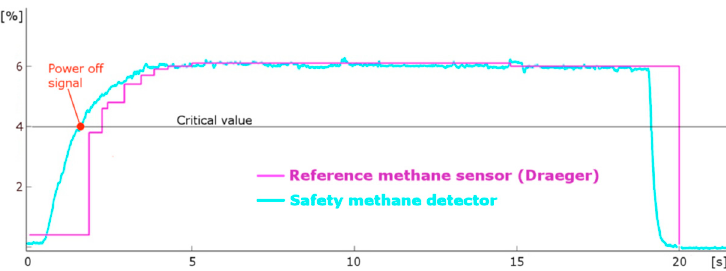
Figure 14. Safety methane detector testing (CH 4 concentration [%] over time [s] in a testing